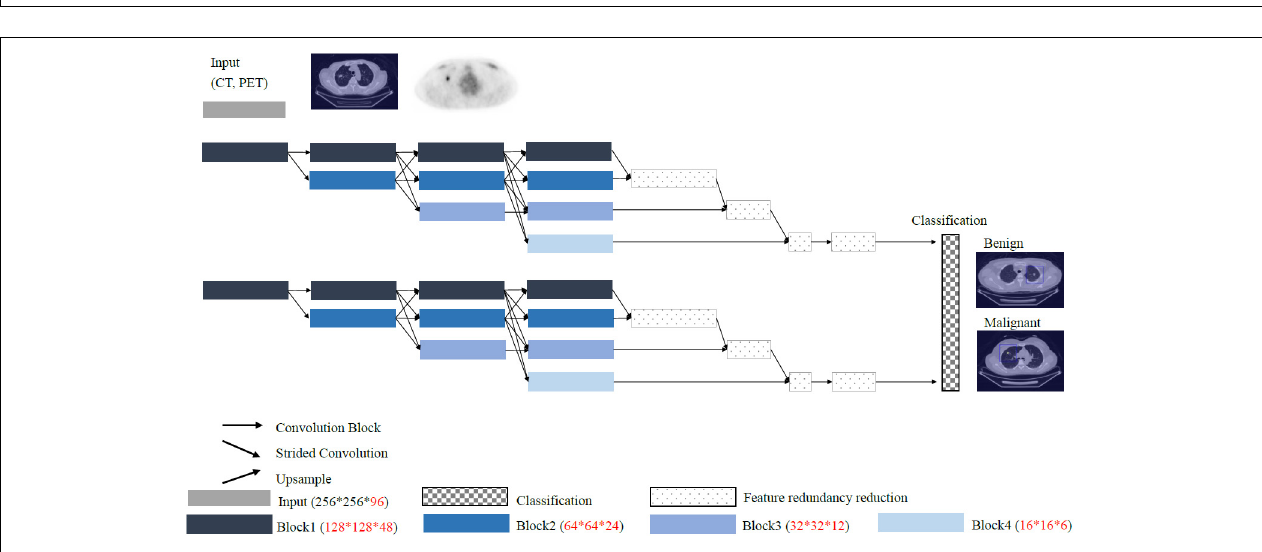
FIGURE 4 | Overall structure of the proposed deep learning model (i.e.,